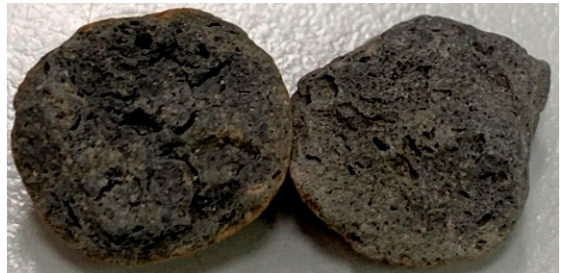
Figure 1. Appearance of lightweight expanded shale aggregates.